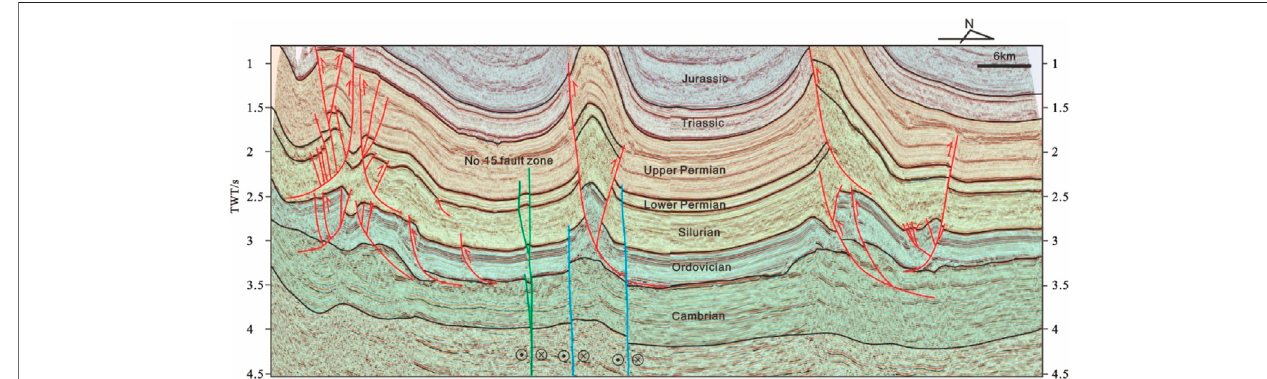
FIGURE 2 | Geological section map of Fuling work area in Sichuan